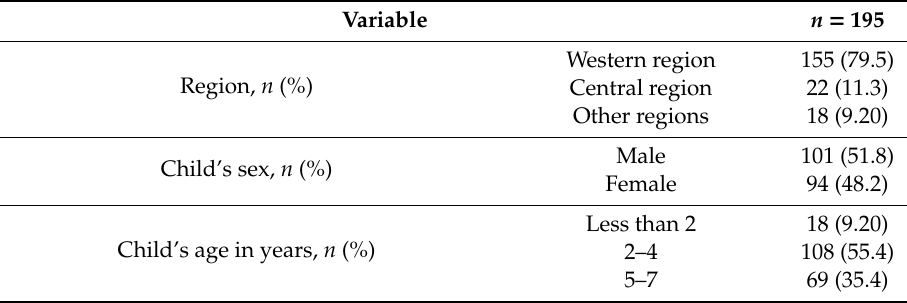
Table 1. Characteristics of the